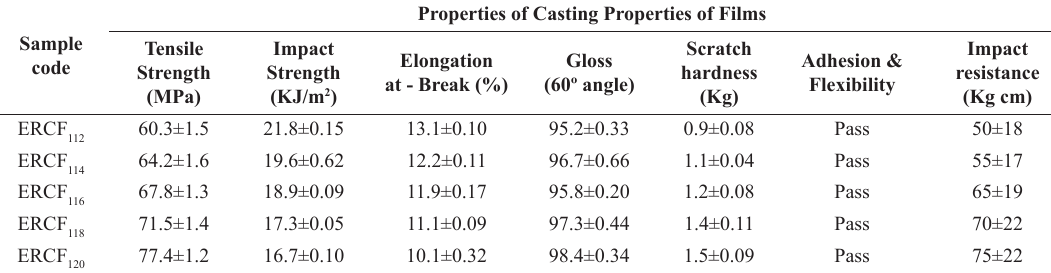
Table 3. Thermal Behavior of isothermally cured sample. S.N.